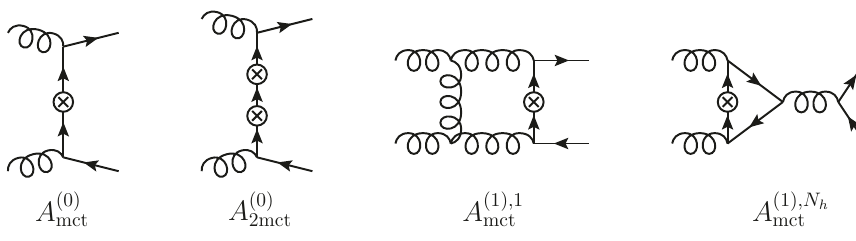
Figure 3. Sample Feynman diagrams with mass counterterm insertions at tree level and one loop that contribute in eqs. (2.5) and (2.6). Black spiral lines and black lines represent gluons and top quarks, respectively. Circled crosses indicate the mass counterterm